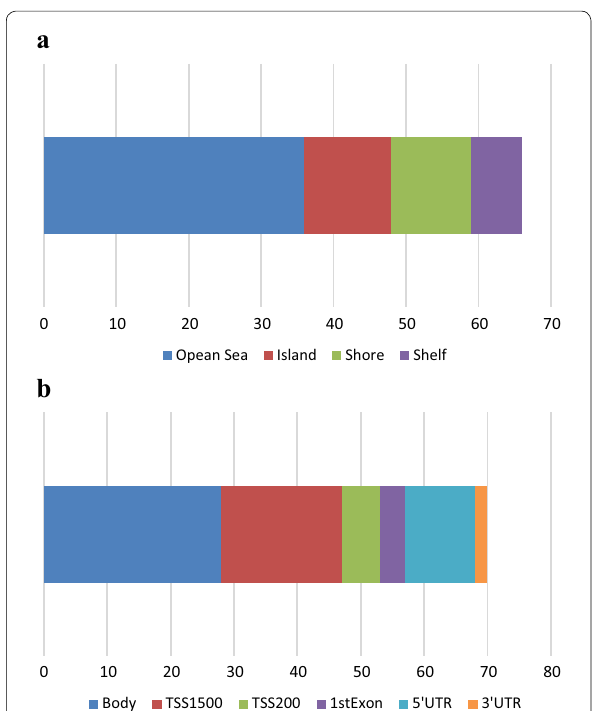
Fig. 2 Functional genomic distribution for the least stable CpG sites over 1‑year period (|Δβ| 0.10). a Depicts the distribution of probes ≥ that fell within CpG Islands (12/66), Shelves (7/66), Shores (11/66) and the Open Sea (36/66). b Depicts the distribution of probes that fell within the gene body (28), 5’ UTR (11), 3’ UTR (2), 1st Exon (4), TSS 1500 (19) and TSS 200 (6)